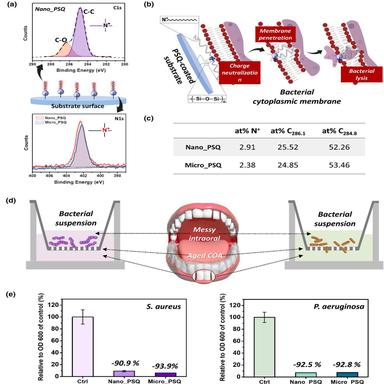
In-vitro antibacterial effects of PSQ coatings. a) XPS spectra showing C1s (top) and N1s (bottom) electron binding energy peaks for PSQ coatings. b) Schematic diagram showing mechanism for occurrence of bacterial lysis and killing by PSQ coatings. c) XPS table showing atomic percentage of quaternized nitrogen and carbon deconvoluted into two peaks (286.1 and 284.8 eV). d) Experimental design that simulates environment where bacterial contamination occurs in oral cavity containing COA. e) Results of measurin